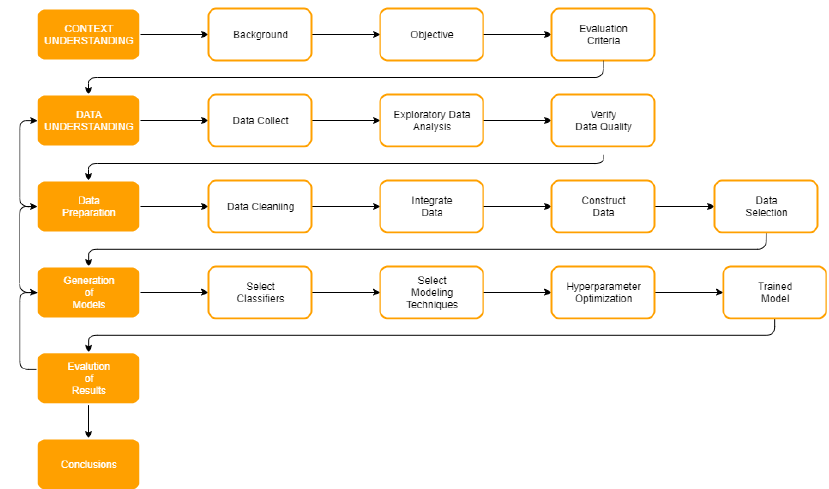
Figure 1. CRISP-DM with adaptation.